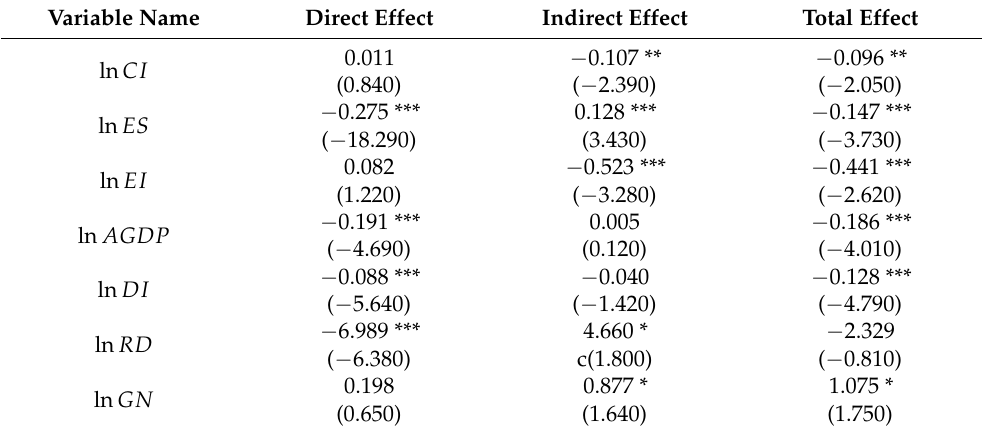
Table 10. Decomposition of spatial effects of China as a